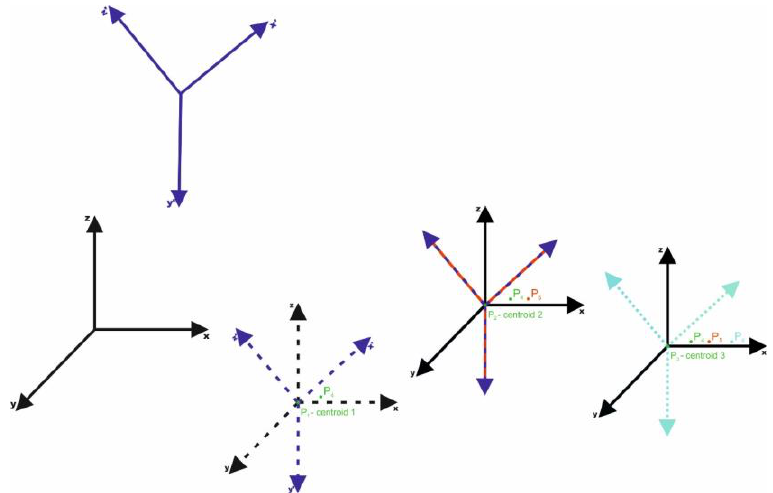
Figure 4. Multi-Centroid Transformation (MCT) with use of three centroids. Table 1. Generating the pairs of points (vectors) in the Hilbert space (Figure 4). New sets (pairs) of points in relation to the centroids are marked in bold. Centroid 1 Centroid 2 Centroid 3 Centroid